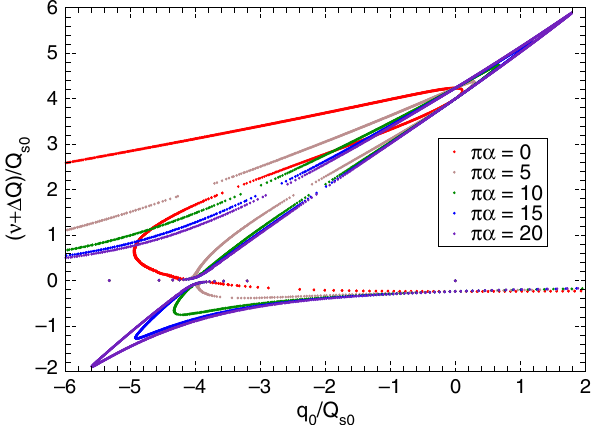
FIG. 12. Lowest eigentunes of the bunch against the exponen- tial wake strength at Δ Q ¼ 4 .